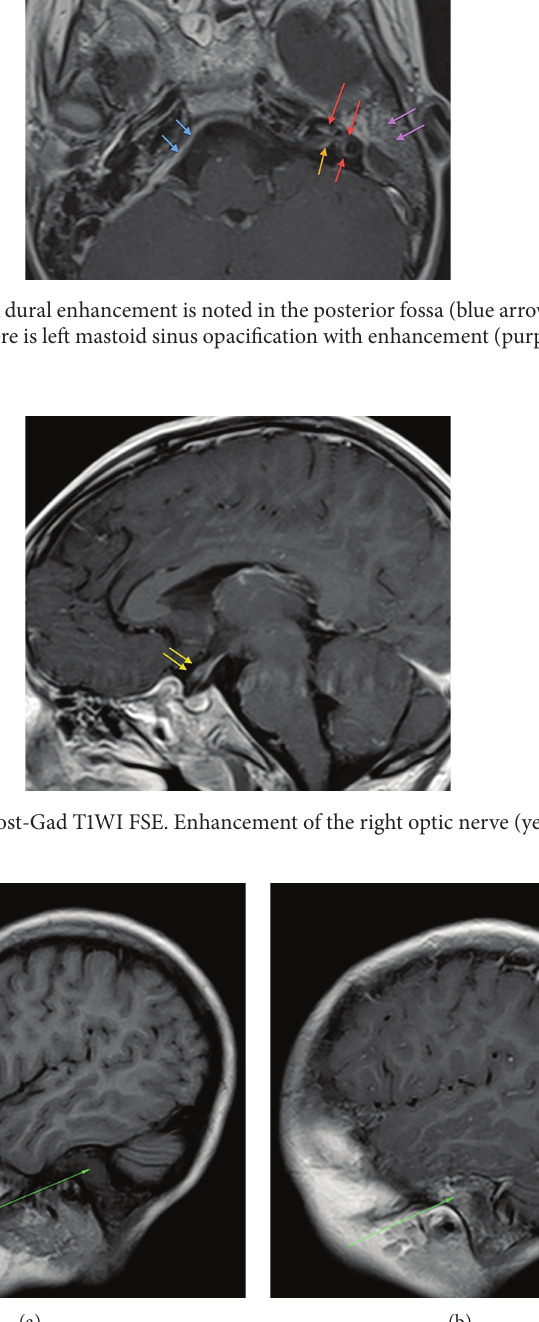
descending segments of the facial nerves. Mild